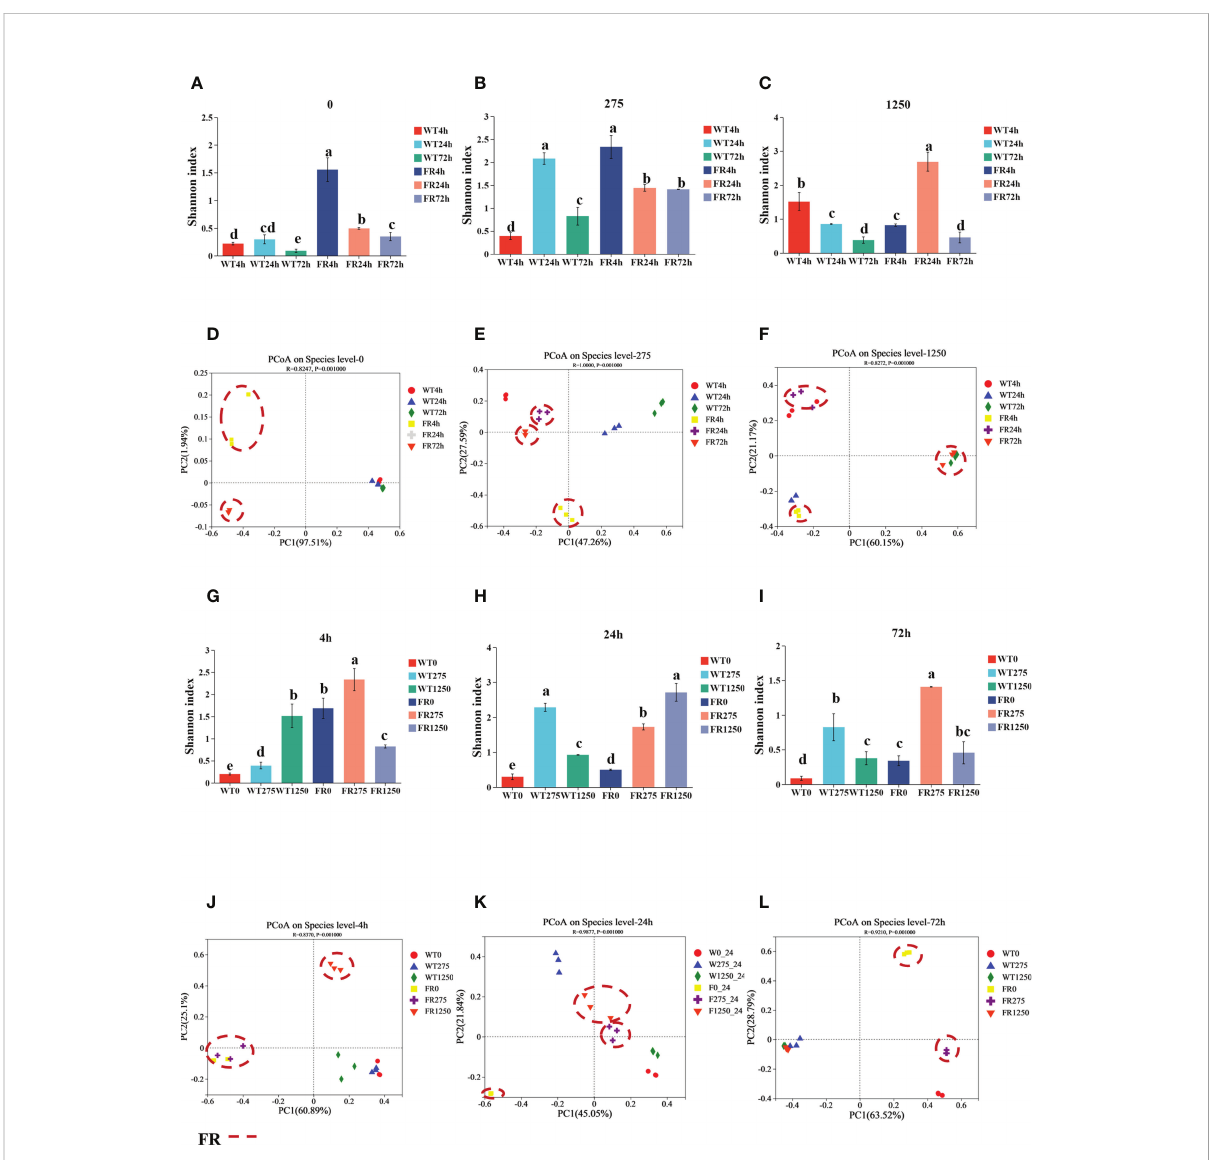
FIGURE 5 Shannon indices and PCoA of saliva-derived oral bio fi lms in the presence of WT/FR. (A-C) The Shannon indices separately at different incubating times of each concentration of NaF (0, 275, 1,250 ppm), standing at 4, 24, and 72 h. (G-I) The Shannon indices respectively at distinctive concentrations of NaF of each timepoint (4, 24, 72 h), representing 0, 275, and 1,250 ppm. (D-F) PCoA separately at different incubating times of each concentration of NaF (0, 275, 1,250 ppm), standing at 4, 24, and 72 h. (J-L) PCoA respectively at distinctive concentrations of NaF of each timepoint (4, 24, 72 h), representing 0, 275, and 1250 ppm. Data are presented as mean ± standard deviation, and different letters demonstrate a signi fi cant difference between groups (P <